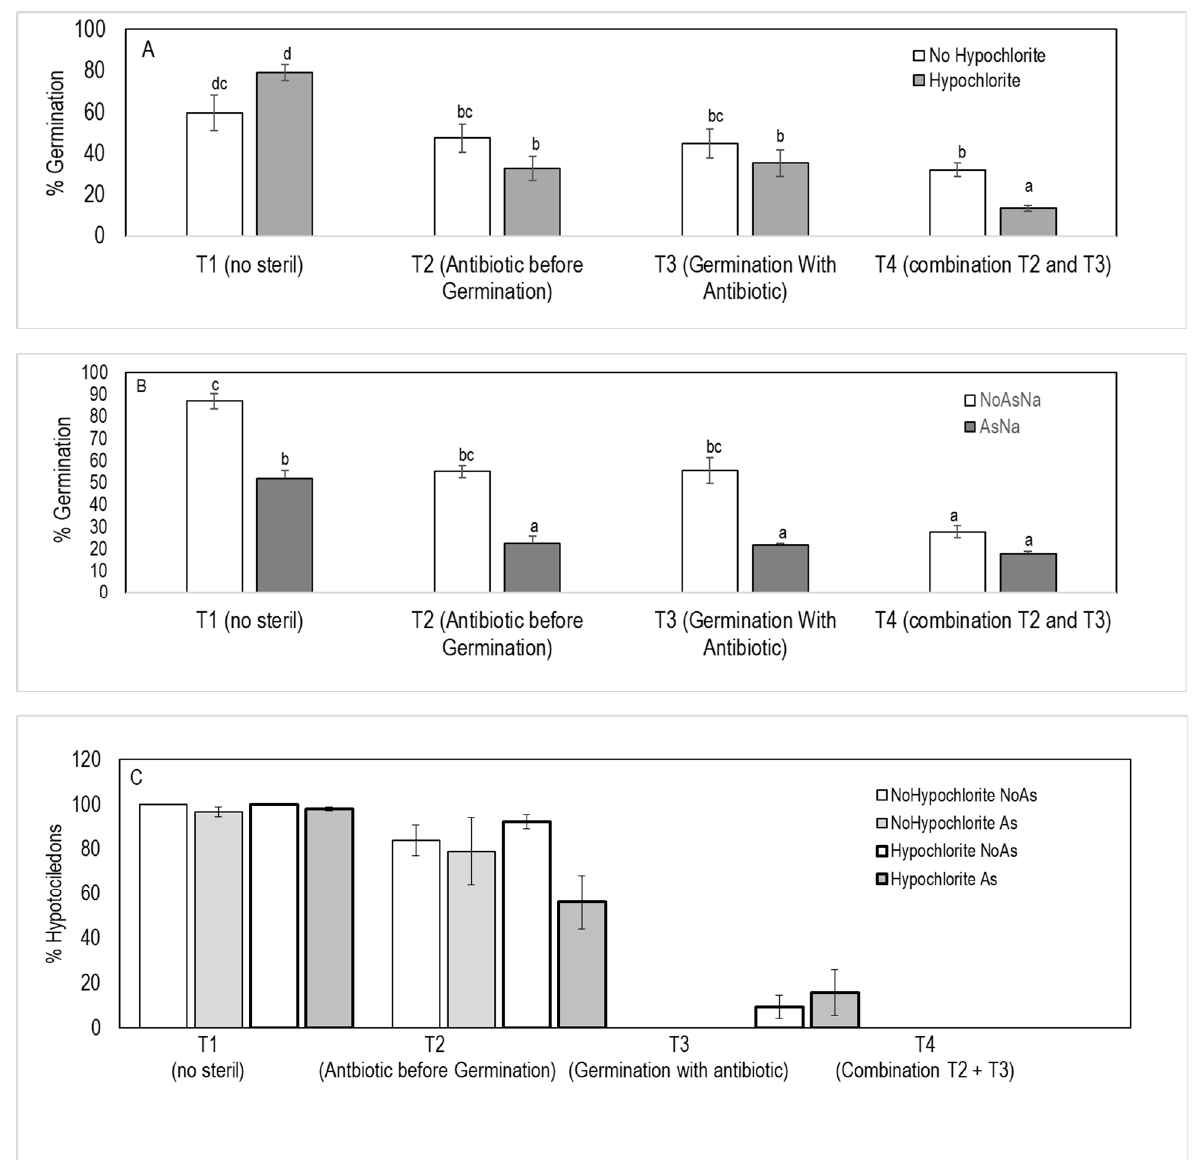
Figure 5. Experiment to analyze the effect of arsenic and hypochlorite washes on functional gnotobiotic J. montana obtained by different levels of sterilization. T1, no sterilization; T2, washing the seeds with streptomycin 24 h before planting; T3, germination for ten days in streptomycin media; T4, combination of T2 and T3. ( A ) and ( B ) show the effect of interaction treatment with As and treatment with hypochlorite on germination. ( C ), the percentage of hypocotyls developed. Different letters mean statistically significant differences.